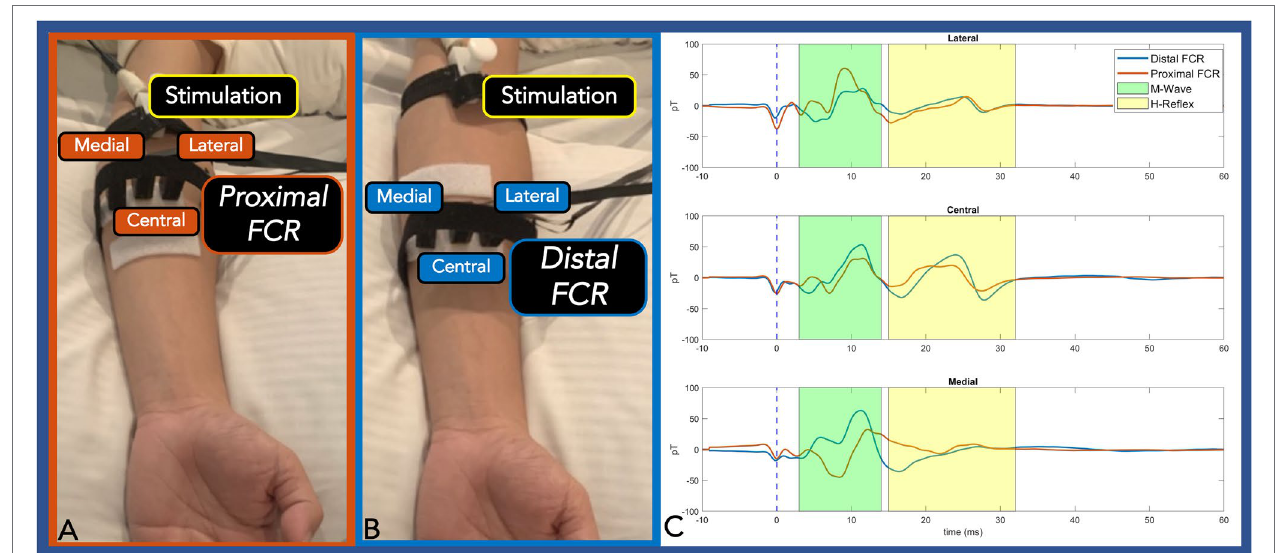
FIGURE 3 | Panel (A,B) : Three OPMs were transversely placed at an equipotential level on the proximal FCR (A) and distal FCR (B) . Panel (C) : The centrally placed OPM (directly over the FCR) exhibited the largest H-Reflex pk-pk amplitude compared with the two radially placed OPM sensors. At the proximal FCR, the lateral and the medial OPM showed reverse polarity. At the distal FCR, where the muscle spindle is thinner, the medial OPM only detected M-Wave activity. The M-wave and the H-Reflex responses are highlighted green and yellow, respectively. (OPM, Optically pumped magnetometers, FCR, Flexor carpi radialis, pT, picoTesla, and ms, milliseconds).